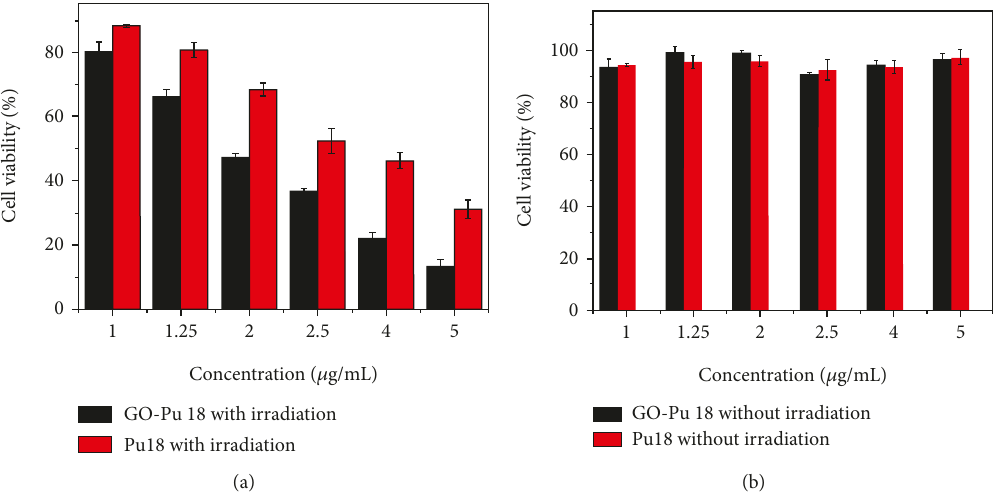
Figure 8: (a) In vitro PDT phototoxicity of GO-Pu18 and free Pu18 to HepG-2 cells and (b) GO-Pu18 composite and free Pu18 to HepG-2 cells without irradiation [93].